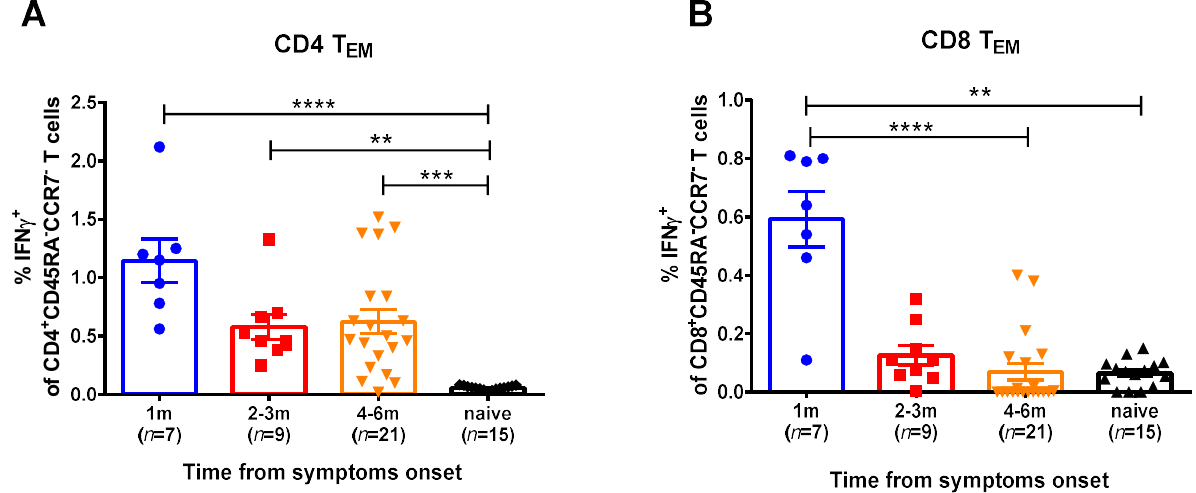
Figure 2. SARS-CoV-2 virus-specific CD4 + ( A ) and CD8 + ( B ) memory T cells in subjects recovered from COVID-19. Proportions of IFN γ -secreting cells among corresponding Tem cell subsets were measured by ICS assay using PBMCs collected at various time after the disease onset. The bars indicate the mean values and the error bars show standard error mean values. Data were analyzed by Kruskal − Wallis test with Dunn’s multiple comparisons test. ** p < 0.01; *** p < 0.001; **** p < 0.0001.